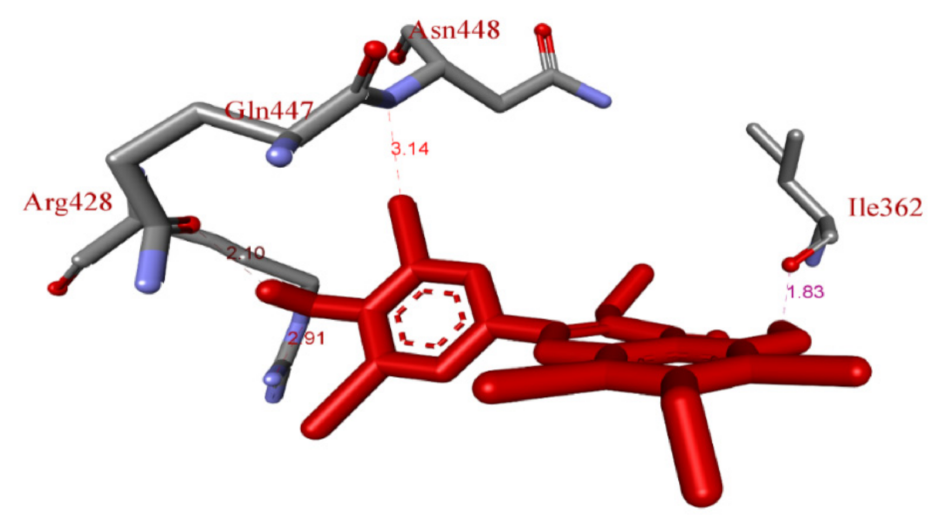
Figure 4. The hydrogen bonds were formed from residual amino acids of the target enzyme 4J5T to functional groups on the most stable conformation ligand 11 .